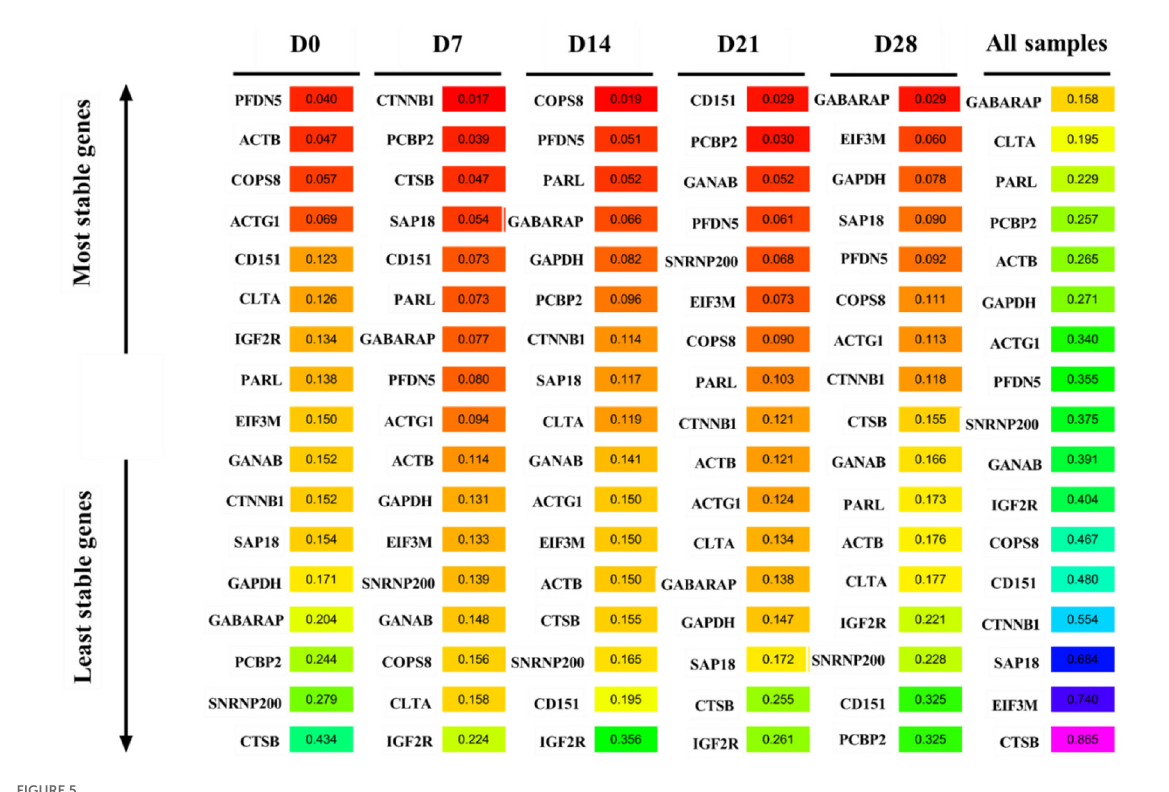
FIGURE5 Normfinder analysis the average expression stability of candidate reference